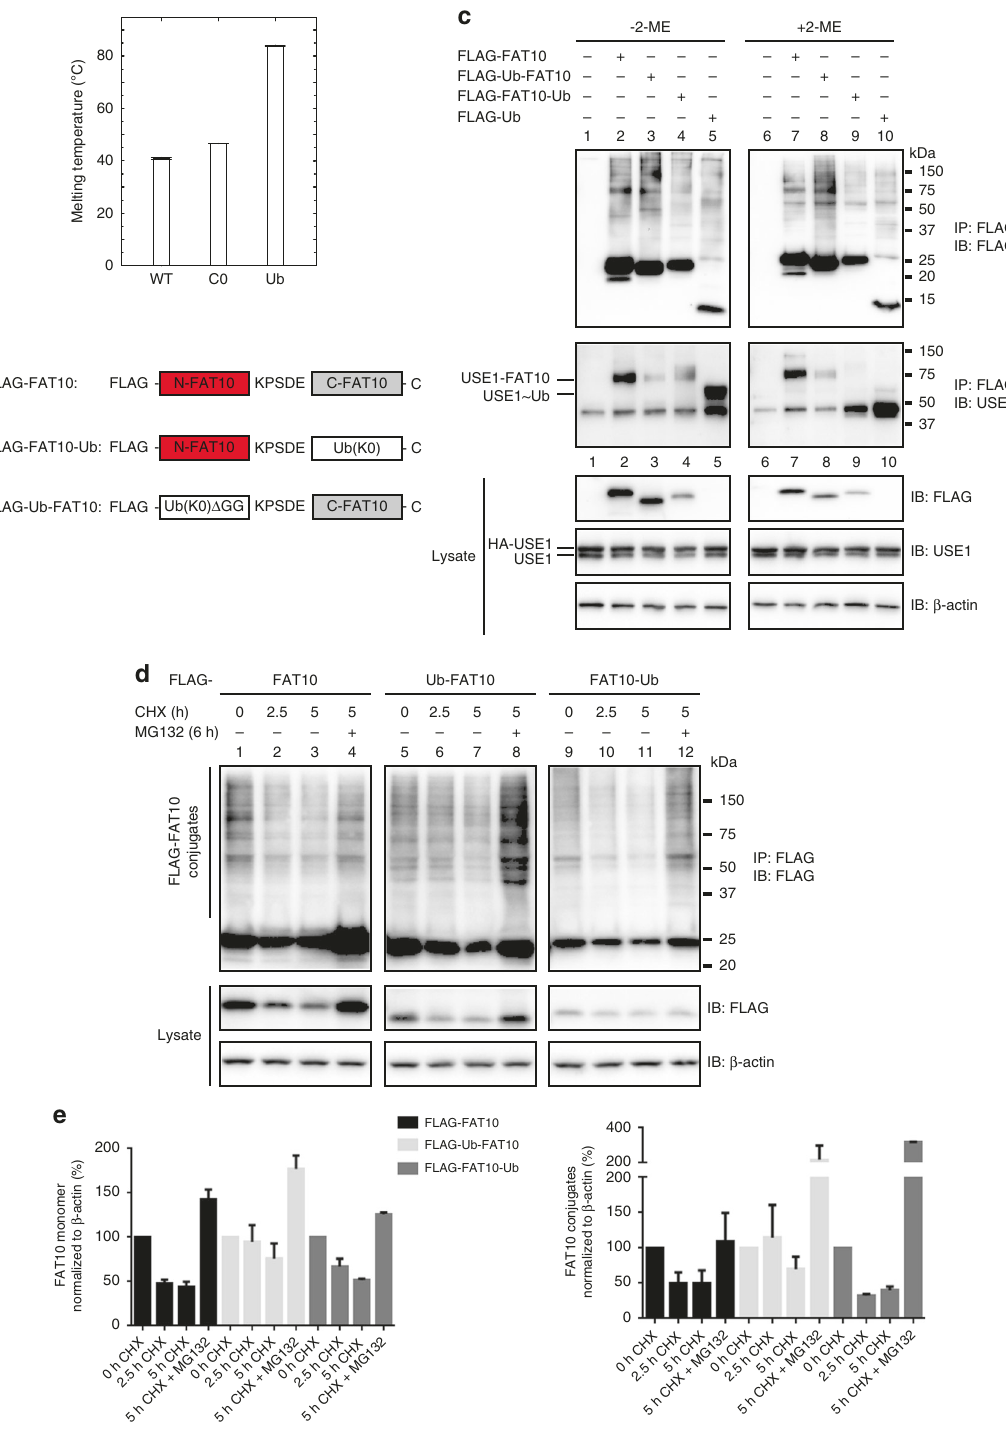
cellulo, we compared the degradation rates of FLAG-tagged WT FAT10 and the Cys-free mutant with the C134L mutations in the C-domain (FLAG-FAT10-C0-C134L) (Fig. 5a). For both WT and Cys-free FAT10, proteasome inhibition led to an accumulation of FAT10 monomer and conjugates in CHX chase experiments (Fig. 5a; lanes 6 and 11). However, Cys-free FAT10 monomer and NATURE COMMUNICATIONS| (2018) 9:3321 |DOI: